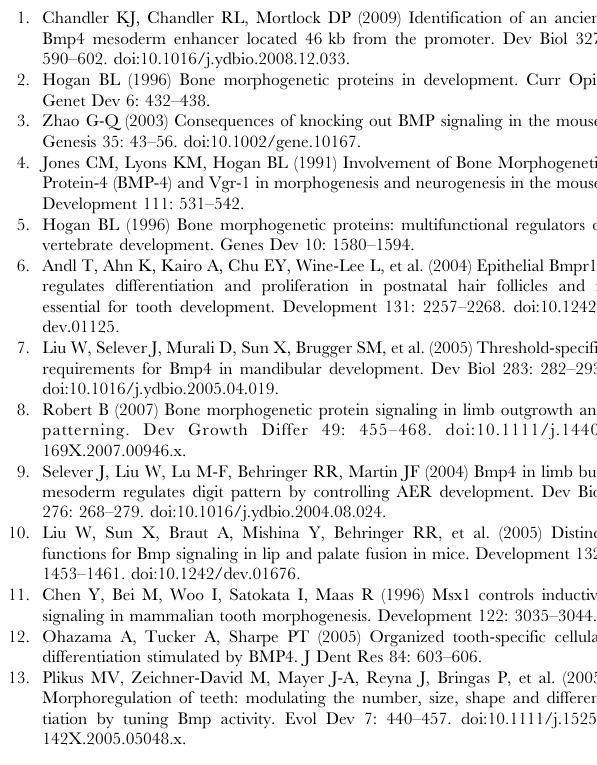
sequence contained is underlined. Figure S5 In vitro binding of Msx to the minimal Bmp4 enhancer. Electrophoretic Mobility Shift Assay (EMSA) exhibits robust binding of Msx2 protein to both a positive control MBS DNA sequence and to the consensus Msx1/2 binding site in the CONS3 sequence. Competition with specific or non-specific cold probes indicates sequence-specific binding of GST-Msx2 fusion protein to the consensus Msx1/2-binding motif. Figure S6 Transgenic mutational analysis of Pitx and Msx binding sites. Graphical representation of the transgenic mutational results presented in Fig. 5B indicates that Pitx binding site is necessary for reporter expression in forelimb and hindlimb AER and mesenchyme and orofacial tissues. Figure S7 Integrative epigenomic analysis suggests that the human orthologous sequence of mouse CONS3 likely functions as an enhancer. Using public epigenomic data from the University of California at Santa Cruz (UCSC) Genome